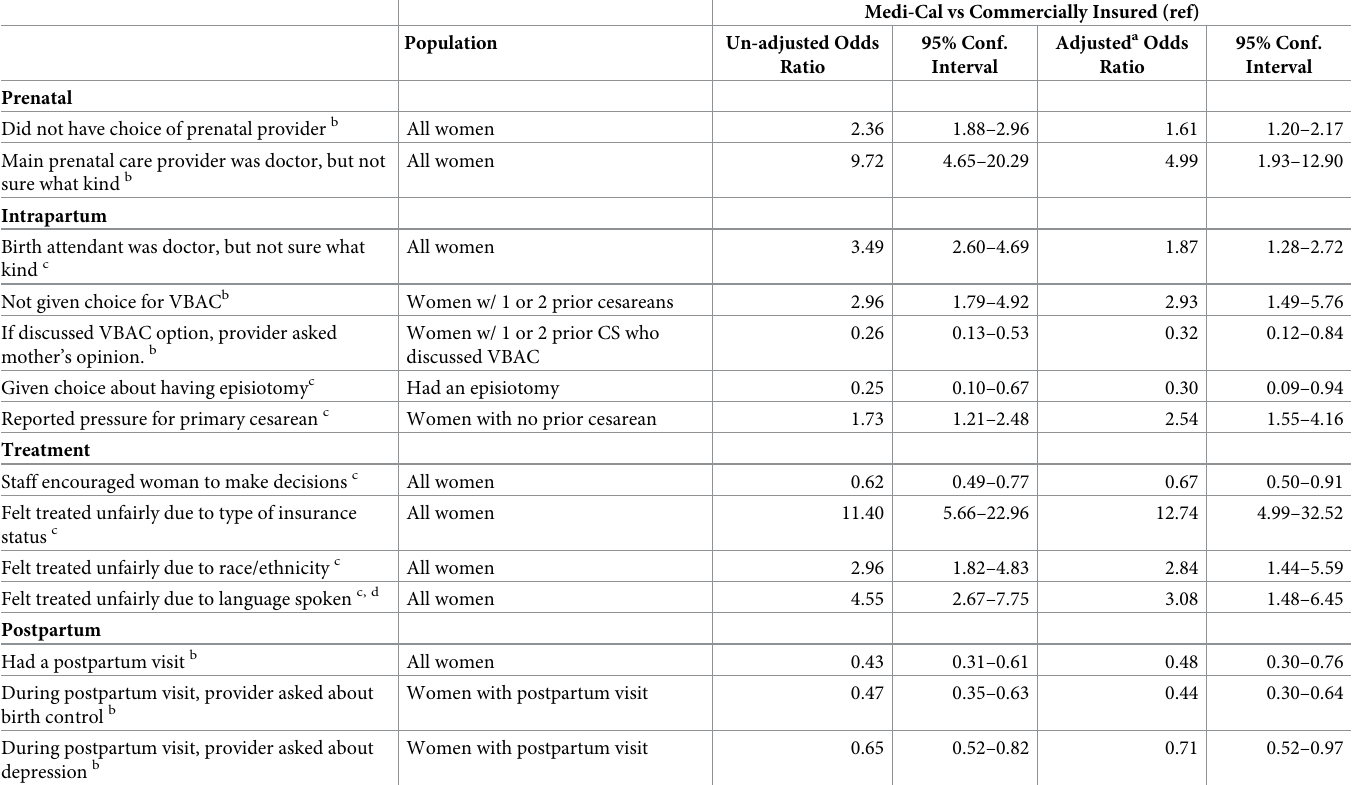
Table 4. Unadjusted and adjusted a odds ratios for outcomes associated with Medi-Cal insurance